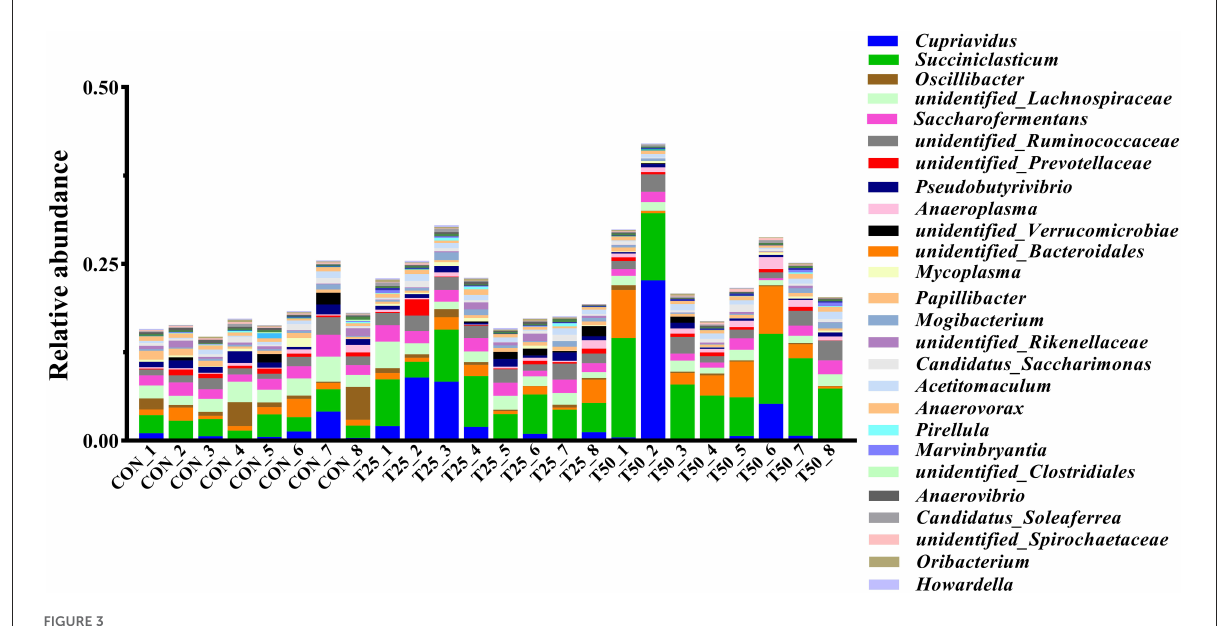
FIGURE3 The abundance of the rumen flora in genus level.